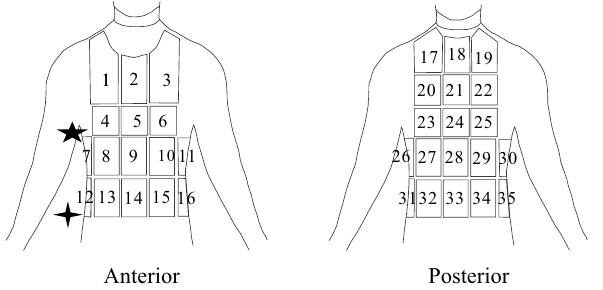
Figure 1. Schematic representation of the installed absorbent pads onto the upper body divided into 35 regions for profiling sweat distribution. The figure was created using Coreldraw Version